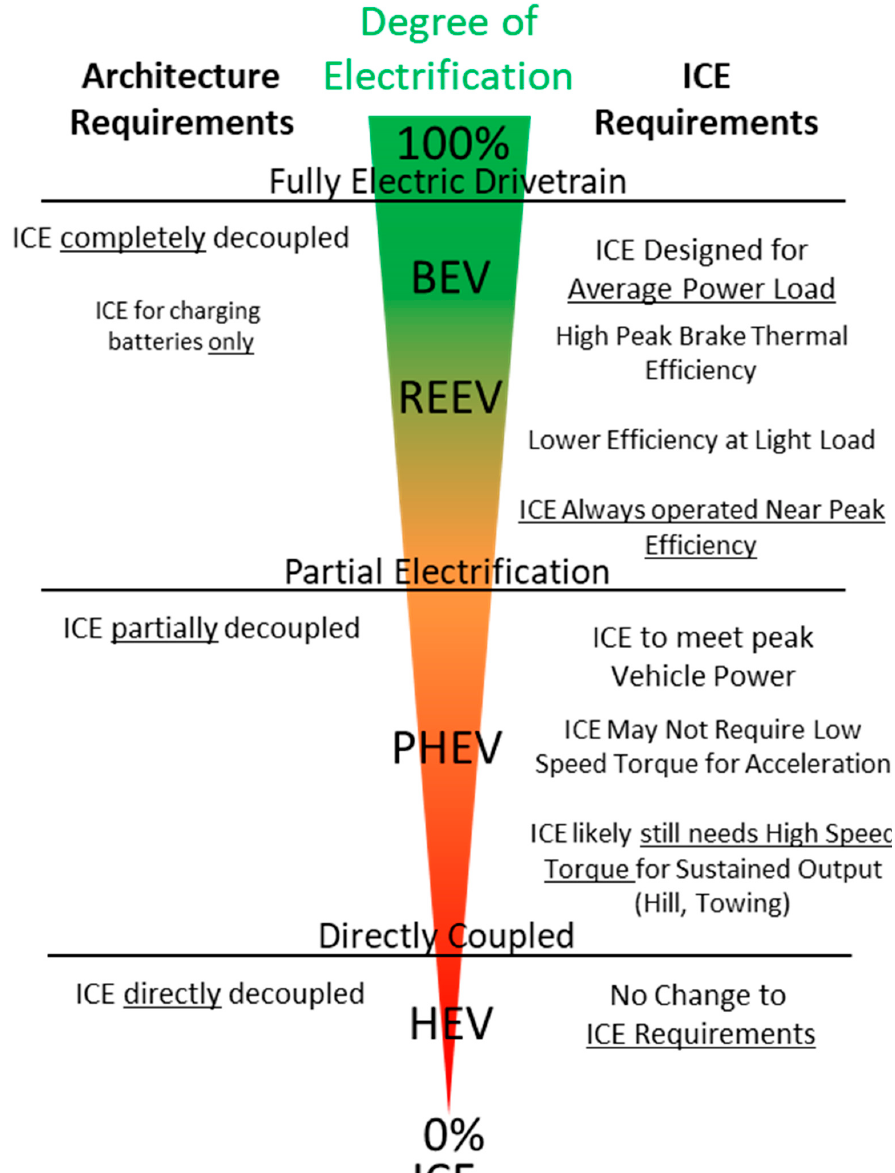
Figure 2. Degree of electrification for different types of electric vehicles.